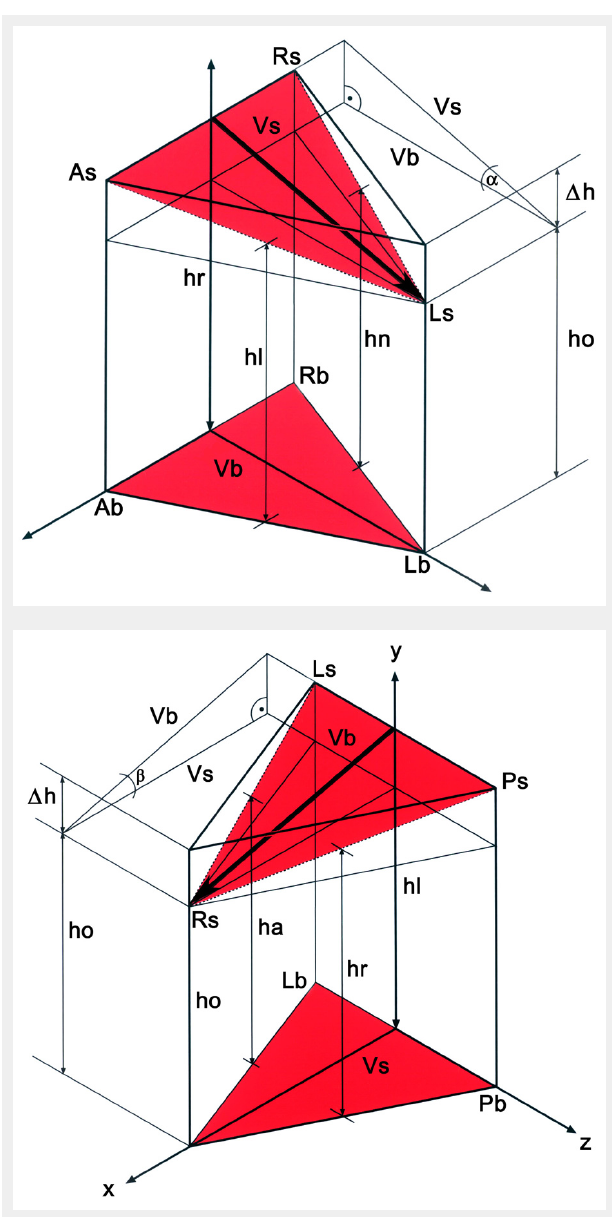
1/A Geometric model of the aortic root. The ‘ AsRsLs ’ triangle is positioned in the sinutubular junction. The three edges correspond to the anterior (As), right (Rs) and left (Ls) commissures. The triangle at the aortic root base is marked by the ‘ AbRbLb ’ triangle, where the basal points correspond to the vertical projection of the three commissures into the root base. By interconnecting the points of both triangles, a model of the aortic root is obtained. ‘ h r’ corresponds to the height measured in the right sinus; ‘ h l’ and ‘ h n’ to the heights obtained in the left and non-coronary sinuses, respectively. ‘ h o’ is the distance between the ‘ Ls’ and ‘ Lb’ respectively. ‘∆ h’ is calculated as the difference between ‘ hr ’ and ‘ h o’. The ‘ Vs ’ height of the ‘ AsRsLs ’ triangle also was calculated. One can observe that the tilt angle between the basal and sinutubular triangles corresponds to the ‘α’ angle in the triangle, which is defined by ‘∆ h’ and ‘ Vs ’. The ‘α’ angle is calculated according to the rules of a right-angle triangle. The tilt angle of the aortic root is 5.47° 1/B Geometric model of the pulmonary root. The ‘ PsLsRs’ triangle is found at the level of the sinutubular junction and is defined by the posterior (Ps), left (Rs) and right (Rs) commissures. The triangle at the aortic root base is marked by the ‘ PbLbRb’ triangle, where the basal points correspond to projection of the commissures onto the inter-valvular triangles. By interconnecting the mentioned points, a 3-D model of the pulmonary root is obtained. ‘ h l’ corresponds to the height measured in the left sinus; ‘ h a’ and ‘ h r’ to the heights obtained in the anterior and in the right pulmonary sinuses, respectively. ‘ h o’ is the distance between ‘ Rs’ and ‘ Rb’ . ‘∆ h ’ is calculated as the difference between ‘ hl ’ and ‘ h o’. ‘ Vs ’ is the height of the ‘ PsLsRs ’ triangle, which also was calculated. One can observe that the tilt angle between the basal and sinutubular triangles corresponds to the ‘ β’ angle in the triangle, which is defined by ‘∆ h’ and ‘ Vs ’. The ‘ β ’ angle is calculated according to the rules of a right-angle triangle. The tilt angle of the pulmonary root is